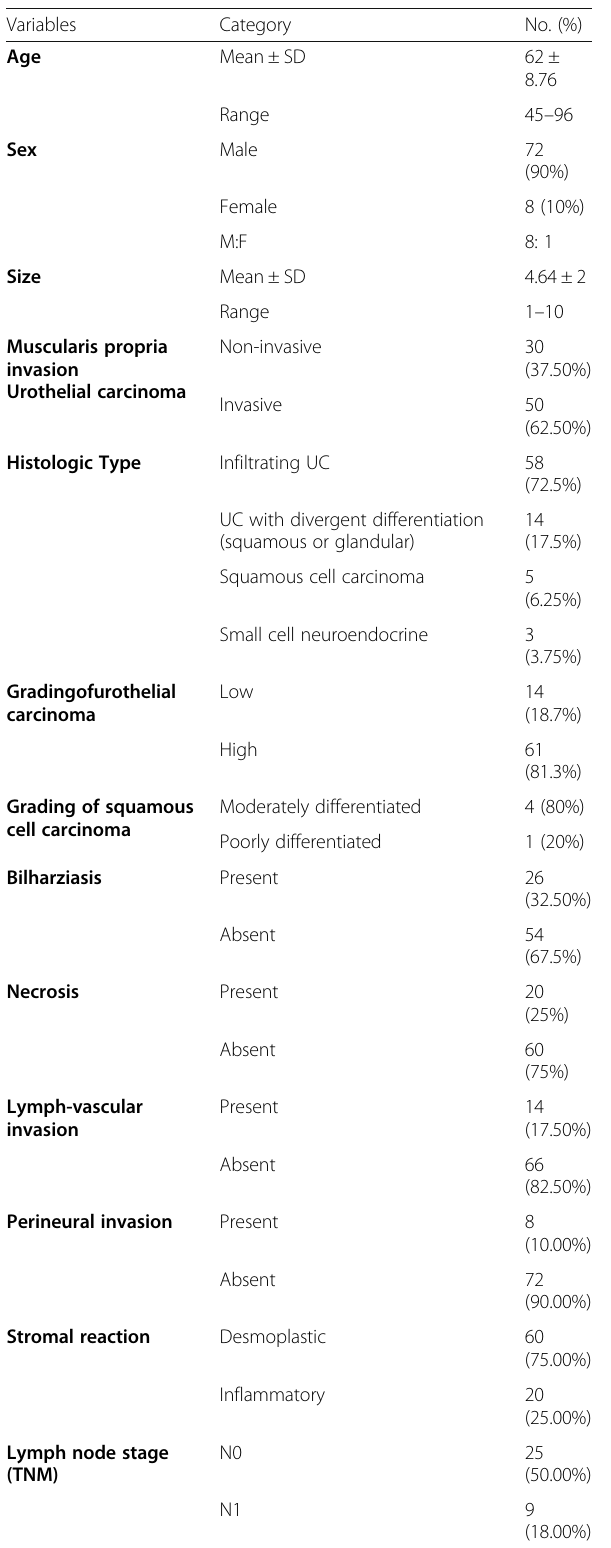
Table 1 Clinicopathological data of the studied bladder